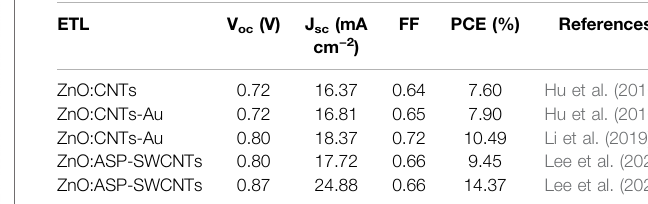
TABLE 4 | Photovoltaic parameters of OSCs employing CNT-based